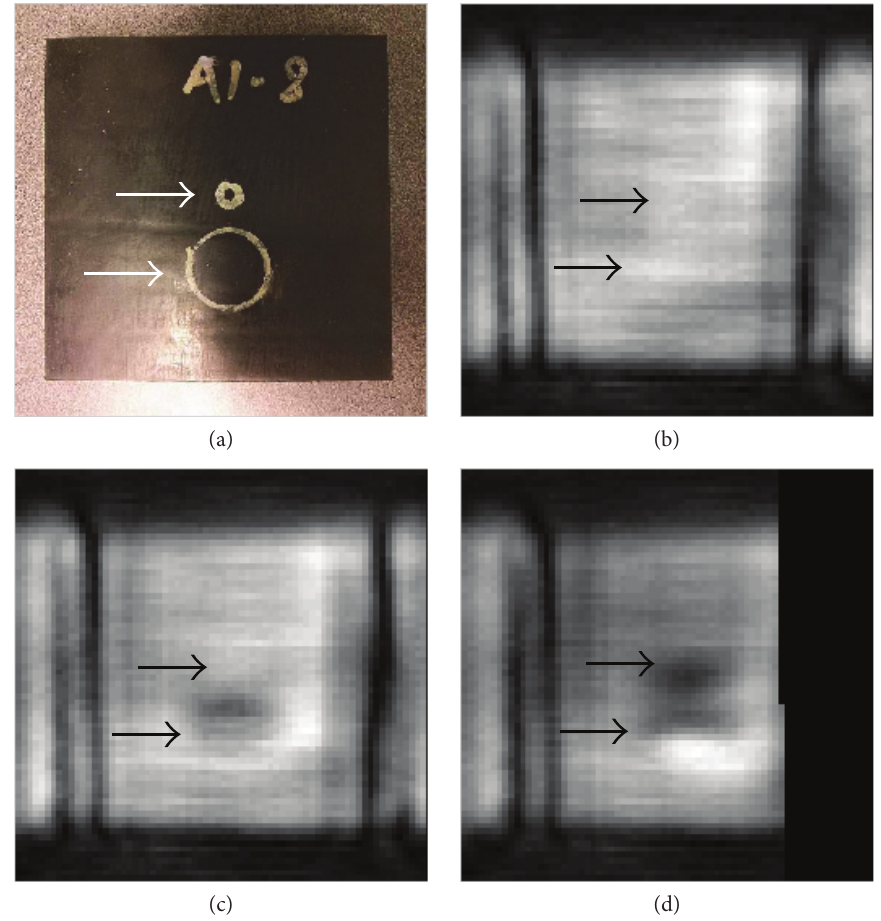
Figure 6: Spectral content re fl ection images ( 70 × 70 pixels ) of tile sample “ A1-8 ” in the range of 80GHz. Positions of the voids are highlighted by the arrows. (a) Color photograph. (b) THz re fl ection image. (c) THz re fl ection image with larger hole fully injected with water. (d) THz re fl ection image with both holes fully injected. Unfortunately, a computer fault interrupted scan (d) before completion. The vertical dark bands at the sides of the tiles are edge e ff ects due to the oblique incidence angle of the THz beam, which also distorts the shapes of the hidden defects horizontally. The acquisition time for each image was approximately 10 hours, limited primarily by the electronics of the raster